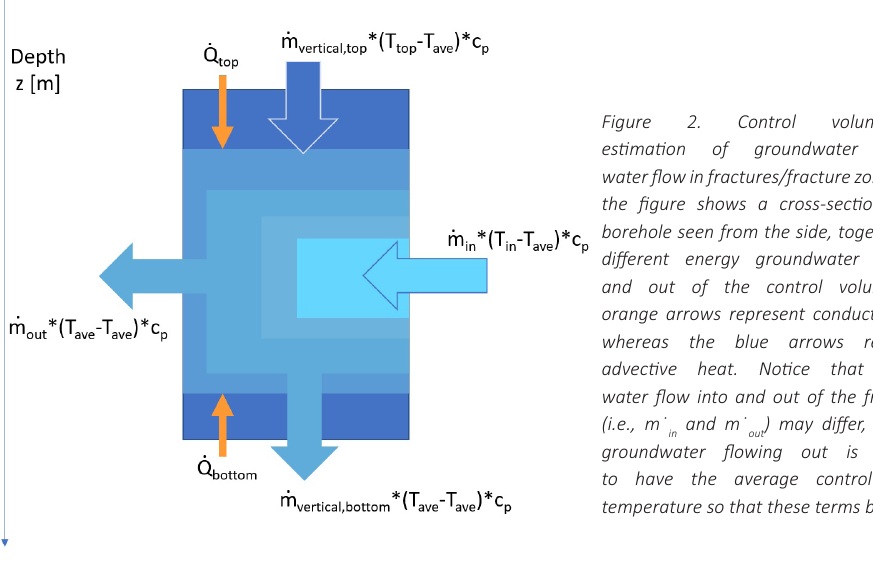
Figure 2. Control volume for estimation of groundwater ground- water flow in fractures/fracture zones (m ̇